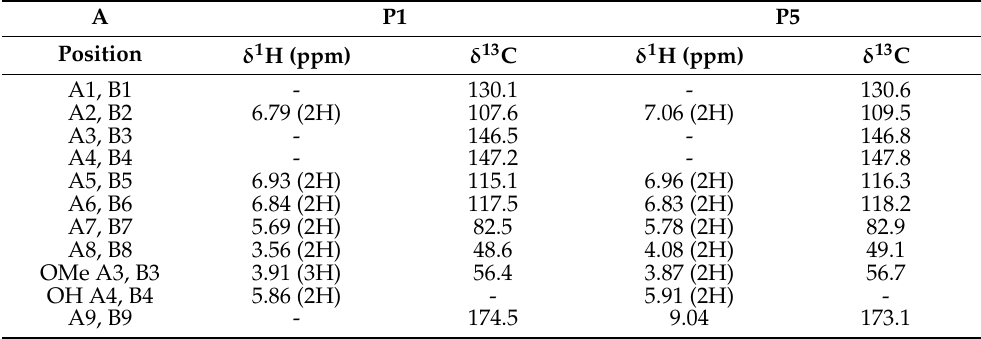
Table 1. 1 H and 13 C NMR data of FA-dehydrodimers of symmetric P1, P5 at 300 MHz in Dimethyl sulfoxide (DMSO).